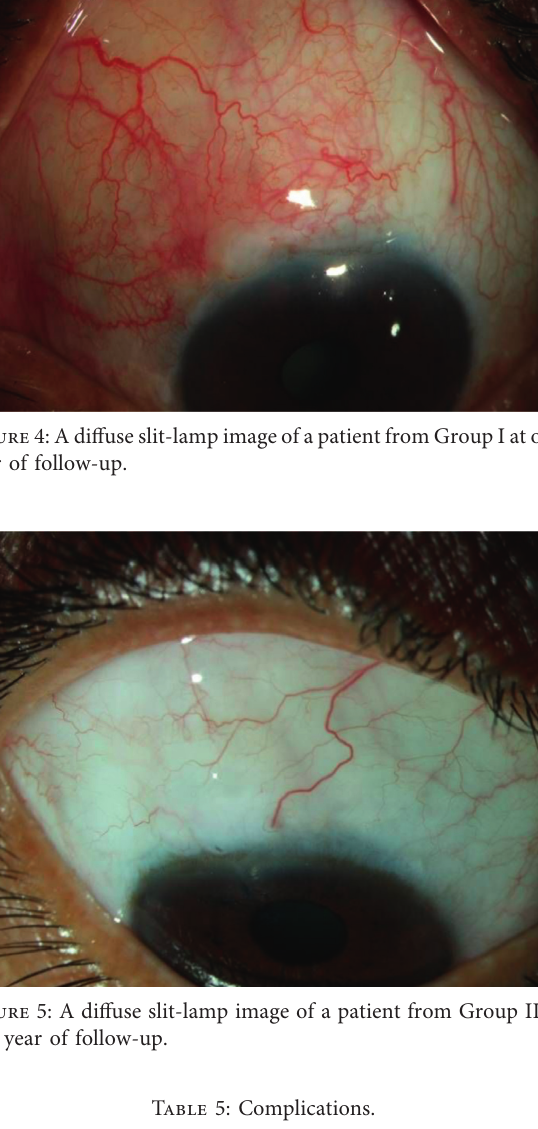
Table 4: Success rate at one-year follow-up.